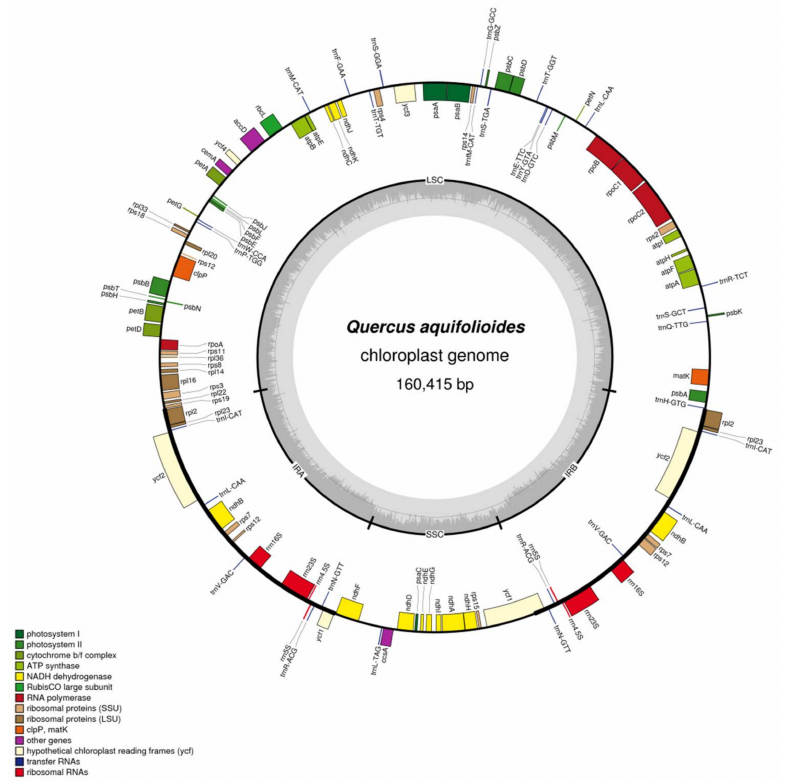
Figure 1. Gene map of the Q. aquifolioides chloroplast genome. The annotated chloroplast (cp) genome of Q. aquifolioides is represented as concentric circles. Genes shown outside the outer circle are transcribed counter-clockwise and genes indicated inside the outer circle are transcribed clockwise. Two inverted repeats (IRs), the large single copy (LSC) and the small single copy (SSC) are shown in the inner